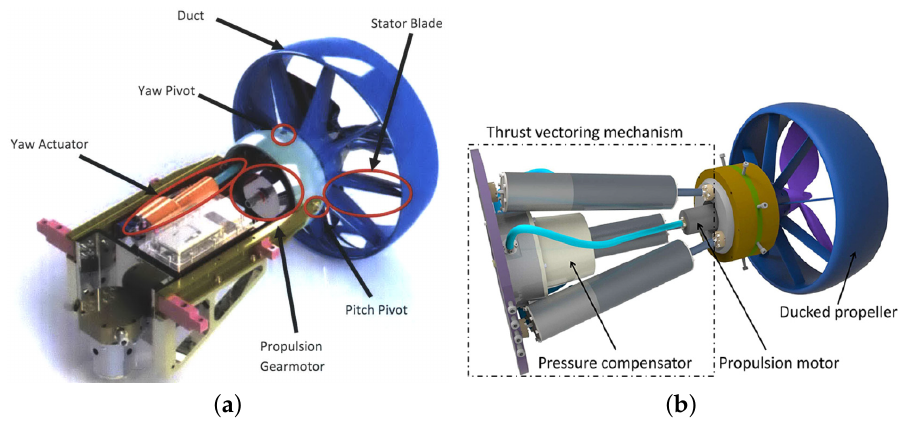
Figure 16. ( a , b ) are two different RT mechanisms for torpedo-shaped AUVs [66,67]. Excluding the proposal in [56,63], all these projects indicate